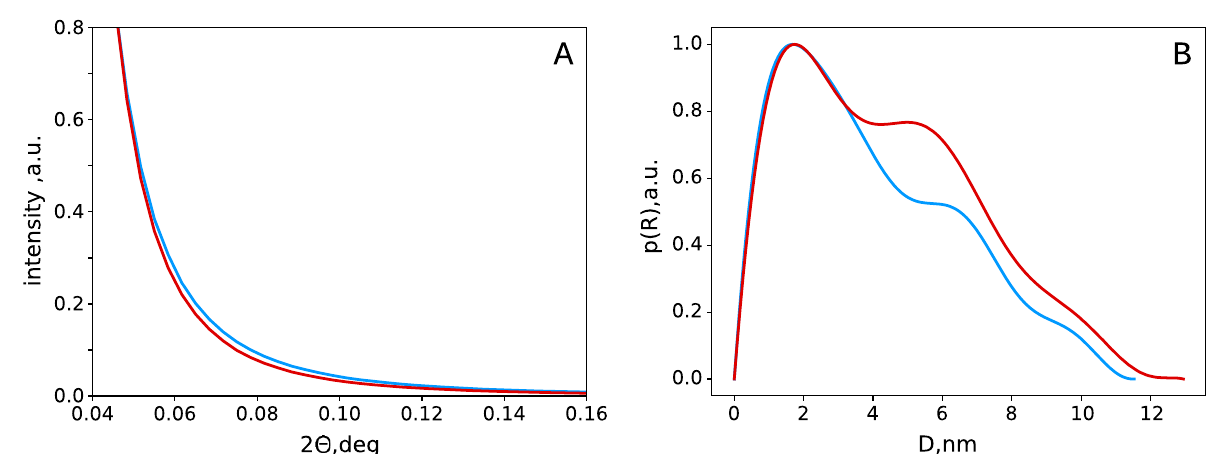
Figure 3. Synchrotron X-ray small-angle ( 1.54 Å in transmission mode) scattering curves ( A ), and the result of their approximation with the model of the infinite cylinders ( B ). The results presented for the initial (blue curve) and mercerized (red curve) cotton linter